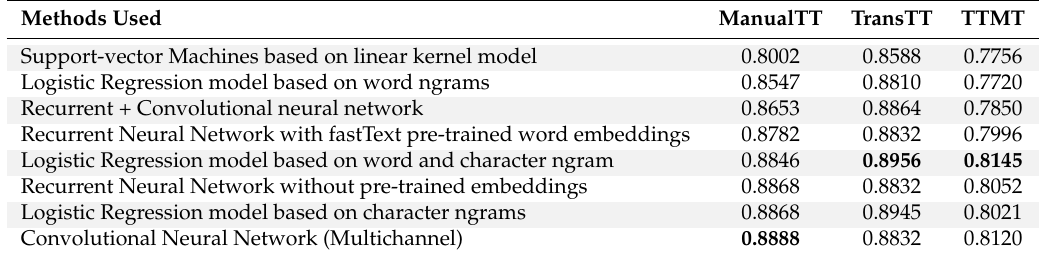
Table 1. Accuracy results with different training and test sets. ManualTT —Manually annotated Training and Test sets. TransTT —Translated Training and Test sets. TTMT —Translated dataset for Training, Annotated dataset for Test